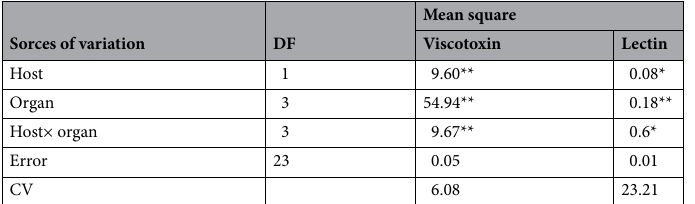
Table 1. Analysis of variance of viscotoxins and lectins concentrations in the foliage and fruit of V. album settled on P. persica and C. betulus in September and December. *,**Indicate a significant difference at 5% and 1% level,